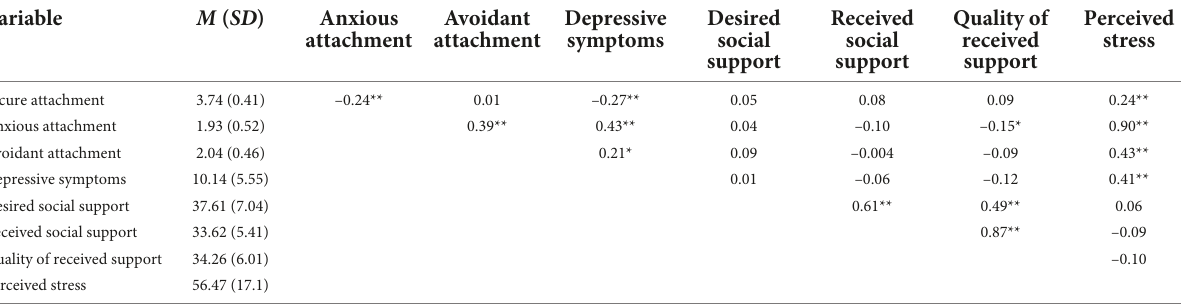
TABLE 3 Pearson’s linear correlation coefficient for the relationship between maternal adult attachment styles with depression, social support, and perceived stress.